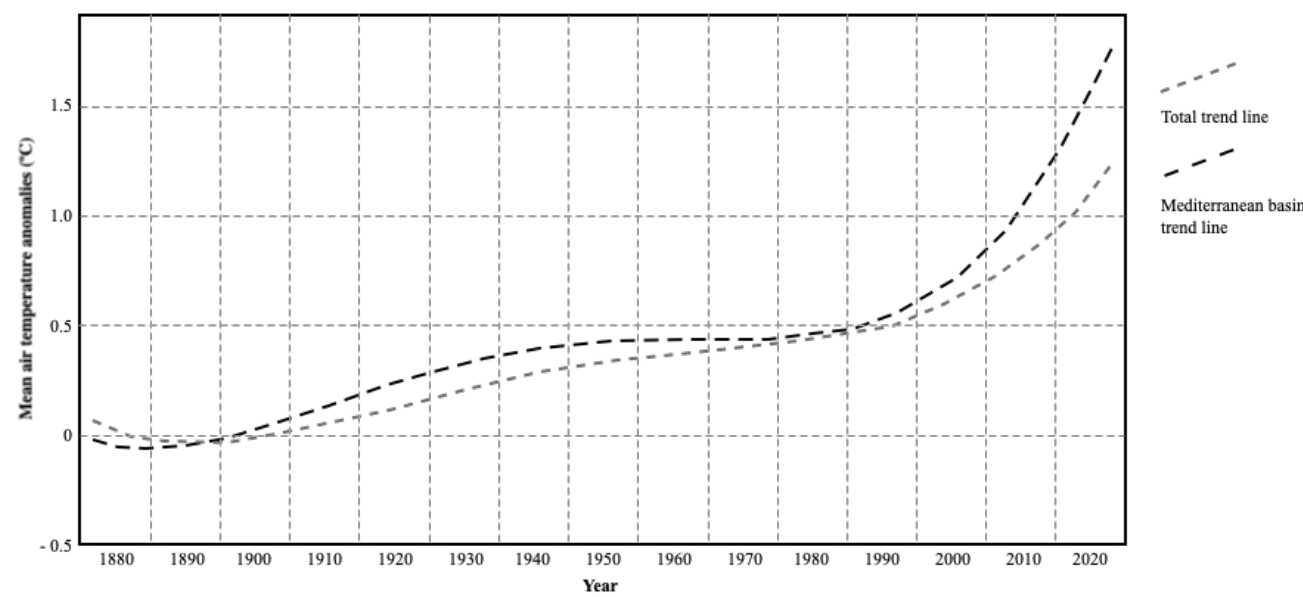
Figure 1. Temporal distribution of annual mean air temperature anomalies on the period 1880–1899 [6]. Table 1. Proportion of forest area by climatic domain in the year 2020 (adapted from